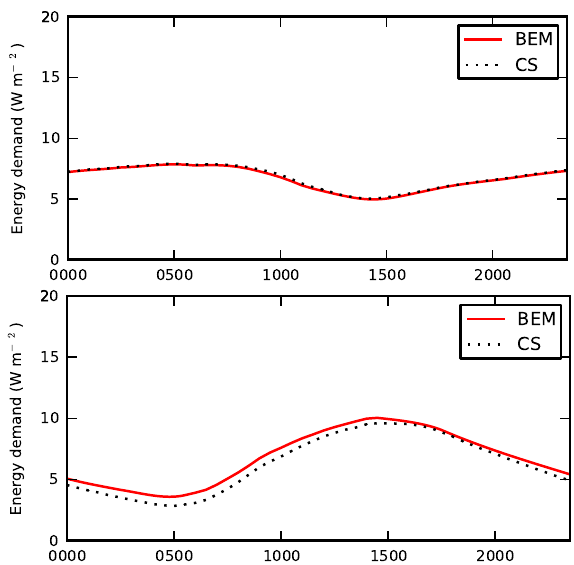
Fig. 7. Monthly-averaged diurnal cycles of heating energy demand between 1 January and 30 January (top) and cooling energy demand between 1 July and 30 July (bottom) per unit of floor area calculated by the coupled scheme and by BEM-TEB for the dense urban centre of Toulouse.